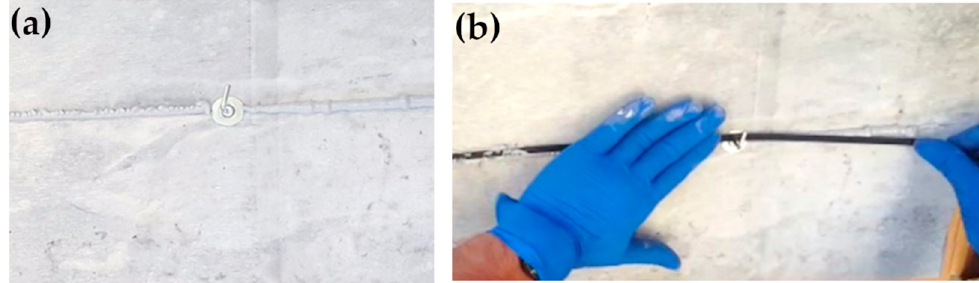
Figure 7. ( a ) Adhesive resin layer applied on the buttress along the path designed for optical fibers. ( b ) Positioning of the sensor cable on the glue